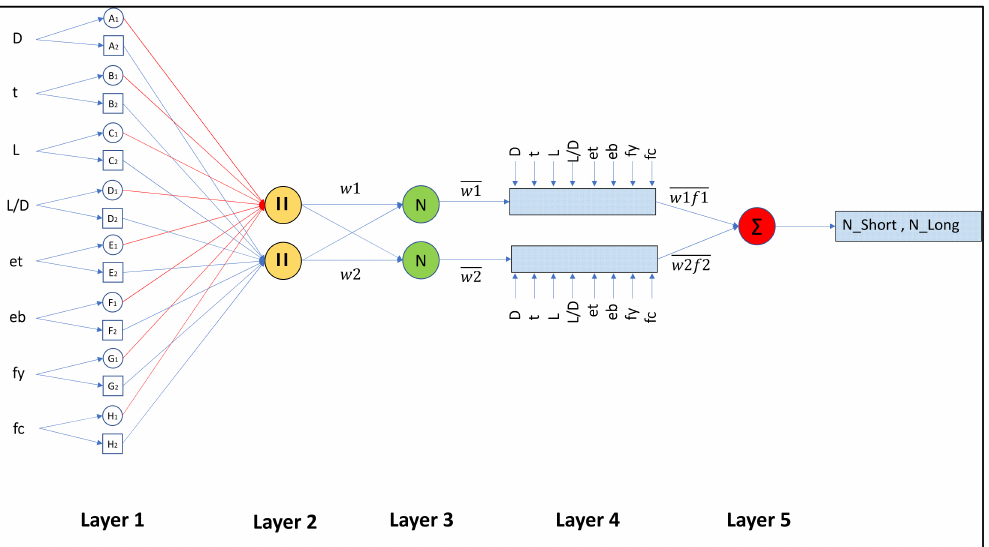
Figure 3. Sugeno ANFIS model schematic layout with eight explanatory